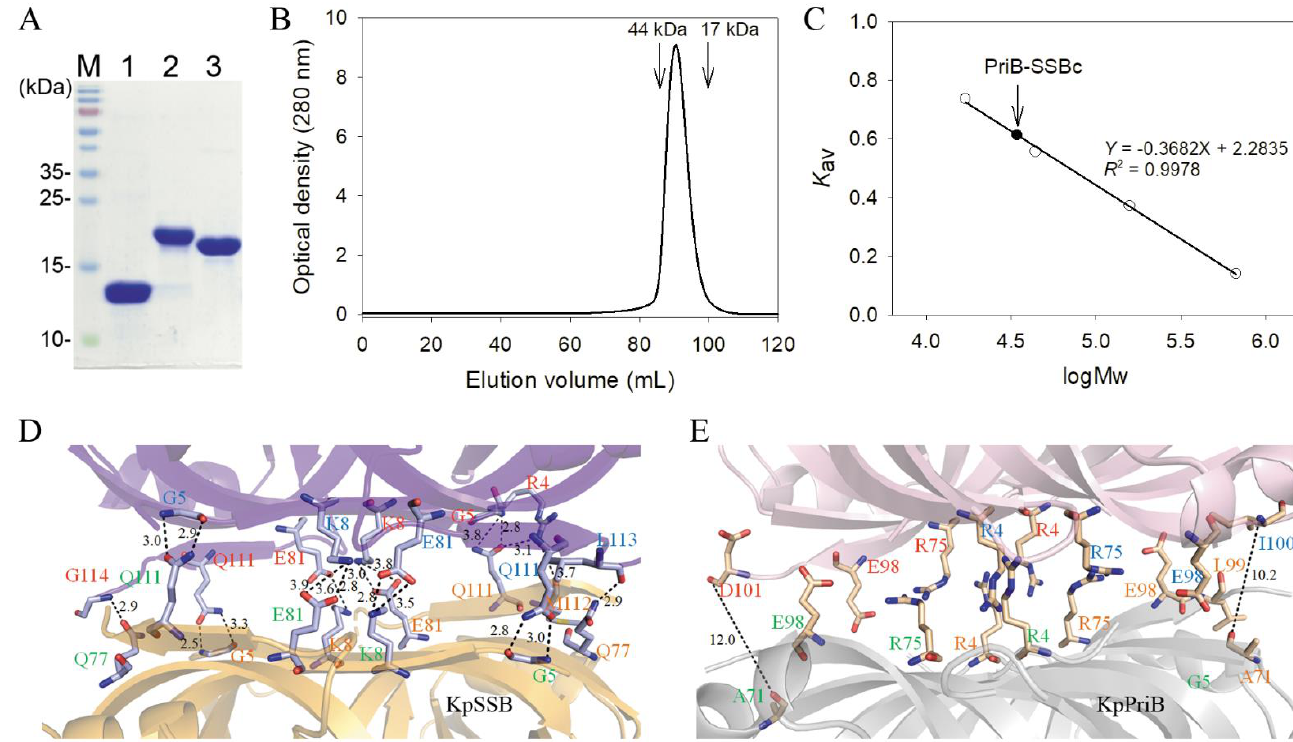
Figure 4. Oligomeric state of PriB-SSBc. ( A ) Protein purity. Coomassie Blue-stained SDS-PAGE (15%) of the purified KpPriB (lane 1), KpSSB (lane 2), PriB-SSBc (lane 3), and molecular mass standards are shown. ( B ) Gel-filtration chromatographic analysis of the purified PriB-SSBc. The corresponding single peak shows the eluting PriB-SSBc. ( C ) Native molecular mass of PriB-SSBc. The native molecular mass of PriB-SSBc was estimated to be 34209 Da, approximately twice as large as that of a PriB-SSBc monomer. ( D ) Structural analysis of the dimer – dimer interface of KpSSB. Many hydrogen bonds and salt bridges were formed at the dimer – dimer interface of KpSSB. These residues from the subunit A, B, C, and D are labeled in red, blue, orange, and green, respectively. The distance ( Å ) of the residues is also shown. ( E ) The superposition of two PriB dimers as the architecture of the KpSSB tetramer. The corresponding residues of KpPriB are not conserved and too far away to interact with each other. Some of them are near to one another but exhibit charge repulsion.